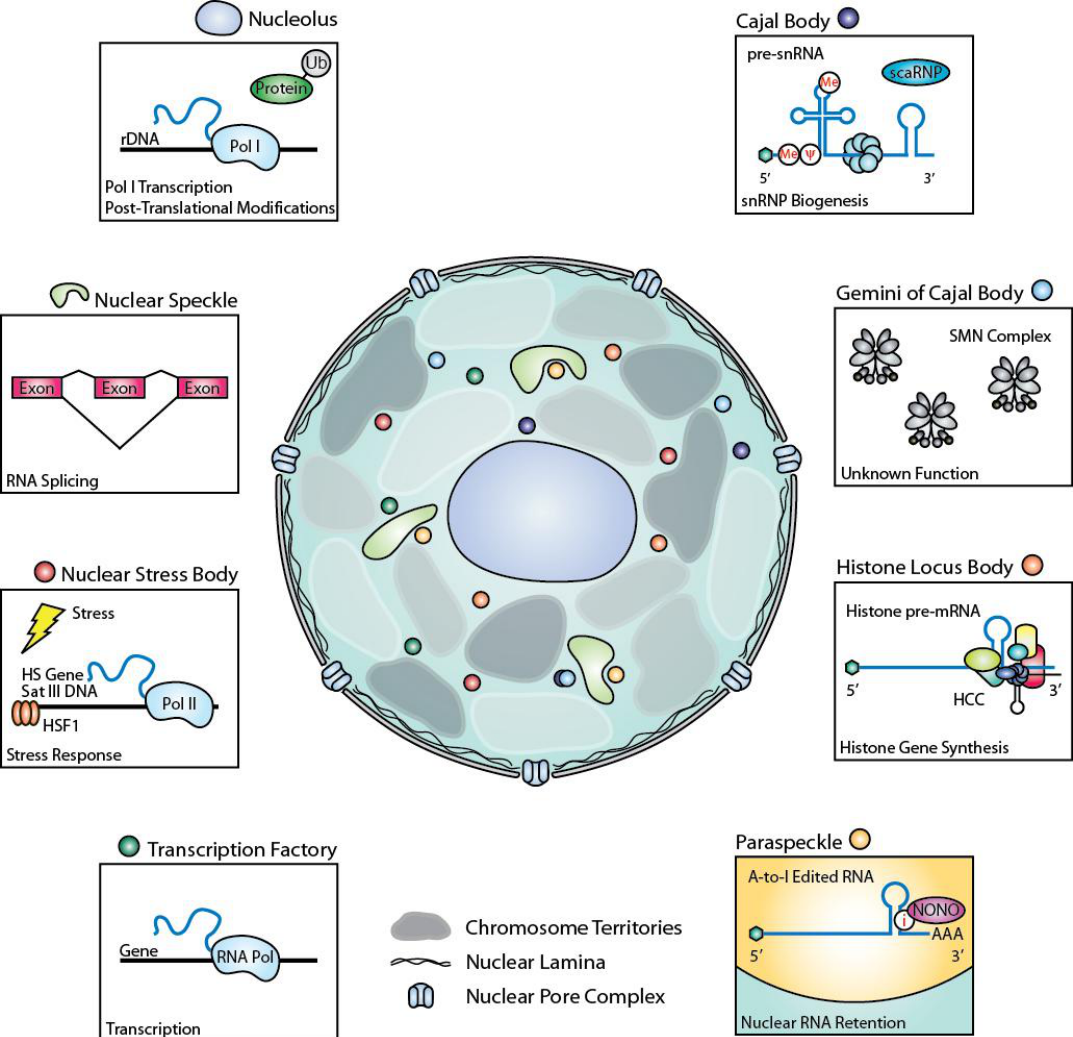
Figure 1. Diagram summarizing the role of nuclear bodies in gene